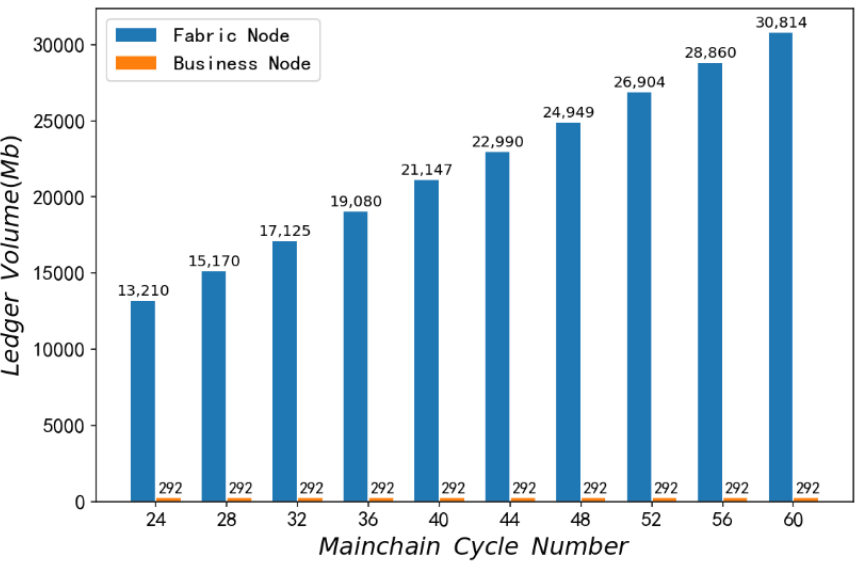
Figure 12. Comparison of the ledger data volume (world state creation and update transactions).